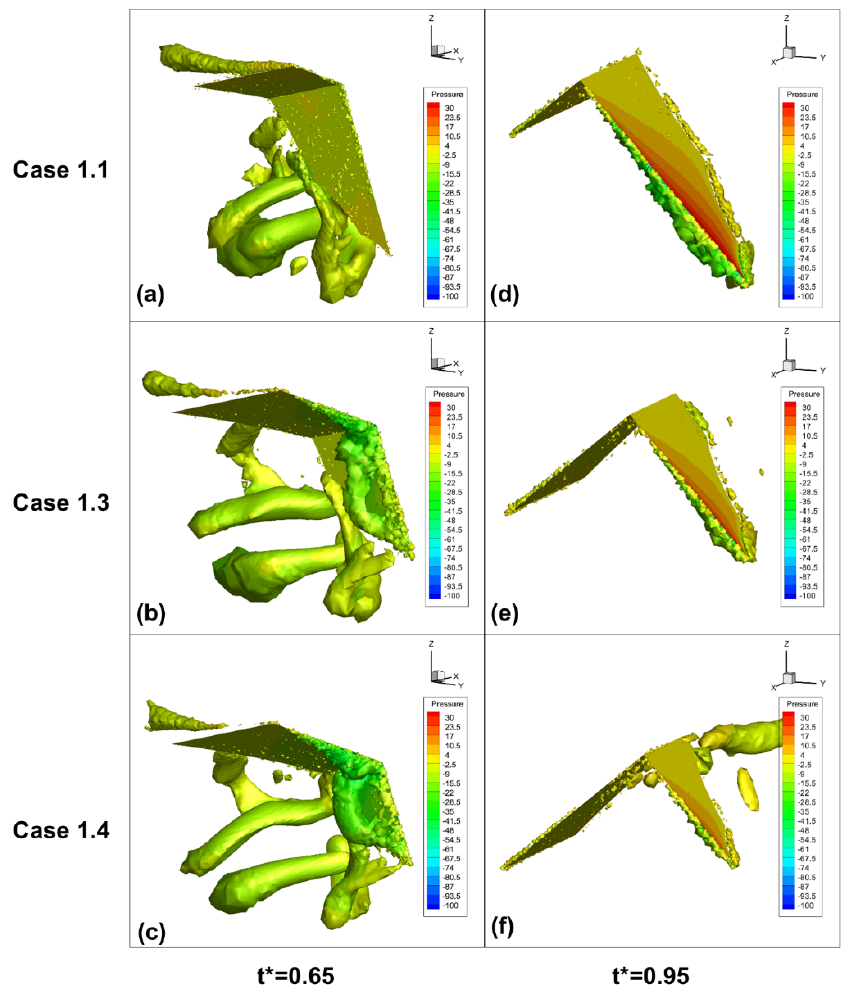
Figure 9. Vorticity during upstroke of typical cases: ( a ) case 1.1 at t* = 0.65; ( b ) case 1.3 at t* = 0.65; ( c ) case 1.4 at t* = 0.65; ( d ) case 1.1 at t* = 0.95; ( e ) case 1.3 at t* = 0.95; ( f ) case 1.4 at t* = 0.95.